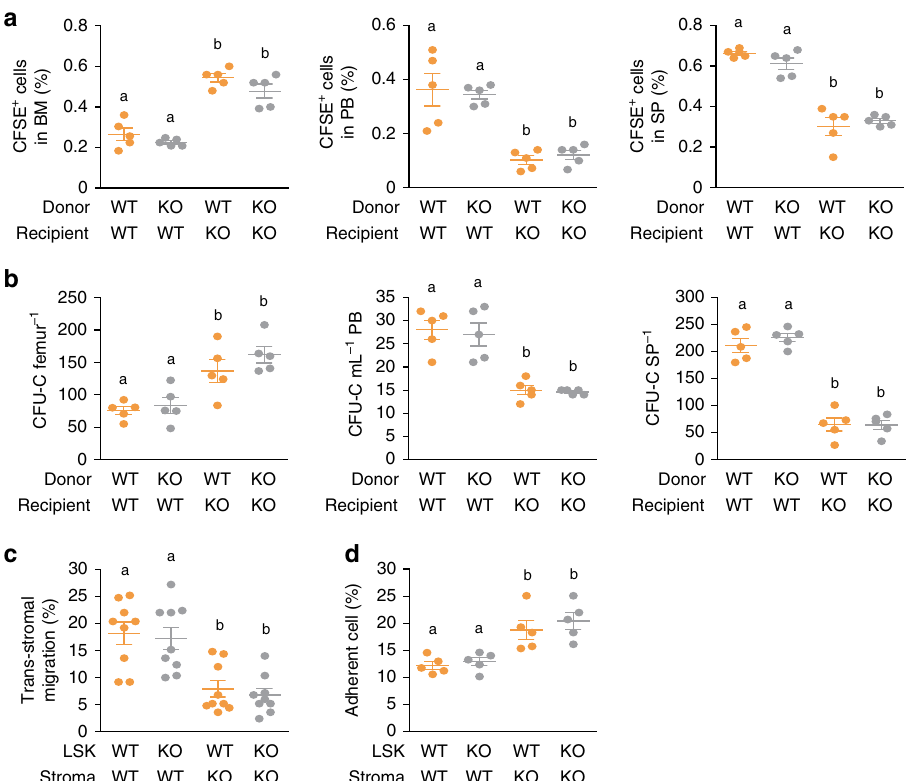
Fig. 4 Phc2 de fi ciency leads to impaired HSPC mobilization from the BM into the periphery via stronger adhesion between HSPCs and BMSCs in BM niches. a , b CFSE-labeled LSK cells from WT and KO mice were intravenously injected into lethally irradiated recipient mice. n = 5 per group. a The frequencies of CFSE + donor cells were measured in the BM, PB and spleen (SP) of recipients at 16 h after injection. b The frequencies of donor-derived clonogenic progenitors (CFU-C) homing to the BM (femur), PB and spleen (SP) of recipients at 16 h after injection. c Relative ratio of migrated WT or KO LSK cells (LSK) through WT or KO BMSCs (Stroma). n = 9 per group. d Relative ratio of adhered WT or KO LSK to WT or KO stroma. n = 5 per group. Statistical signi fi cance was assessed by one-way ANOVA with Tukey HSD analysis. Mean values not sharing the same superscript letter ( a, b ) differ signi fi cantly at P < 0.05. All data are presented as the mean ± SEM. Source data are provided as a Source Data